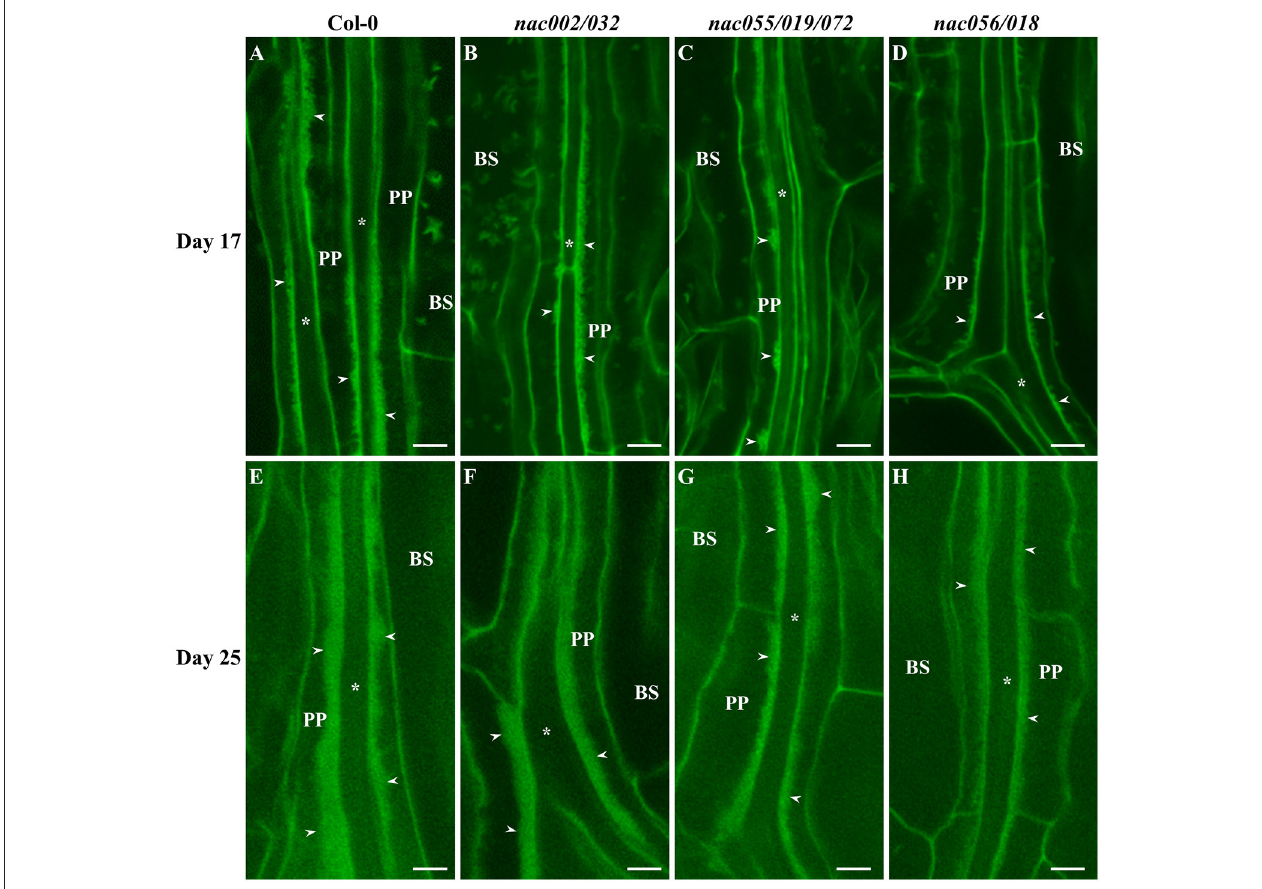
FIGURE 8 | Confocal imaging of wall ingrowth deposition in PP TCs of Arabidopsis Leaf 1 and 2 from Col-0 and nac mutants. By day 17, continuous bands of wall ingrowth deposition were seen in PP TCs from first leaves of both Col-0 (A) and nac002/032 (B) . In contrast, wall ingrowths in nac055/019/072 were deposited as mostly discontinuous patches or clumps (C) , or as discrete projections in nac056/018 (D) . By day 25, wall ingrowths in Col-0 (E) and nac002/032 (F) were seen as thick bands representing massive deposition (Class V; 7–8 points), while bands in nac055/019/072 (G) and nac056/018 (H) appeared to be thinner and occupied less volume of the PP TCs (Class IV; 5–6 points). BS denotes bundle sheath cells; asterisks indicate SE/CCs; PP denotes PP cell or PP TC, as appropriate; arrowheads indicate wall ingrowths in PP TCs. The fluorescent fragments occasionally seen in BS cells correspond to remnant starch grains not completely extracted by the bleach treatment. Scale bars = 5 µ